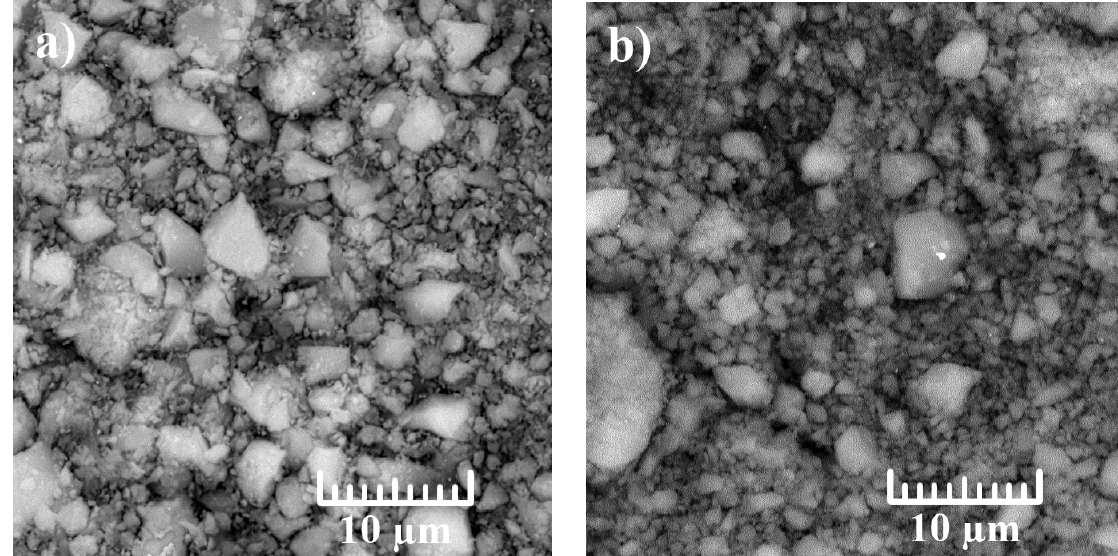
Figure 1. SEM images of MgH 2 –5 wt.% SWCNT, obtained after 60 min of ball milling at speeds of 660 rpm ( a ) and 900 rpm ( b ).